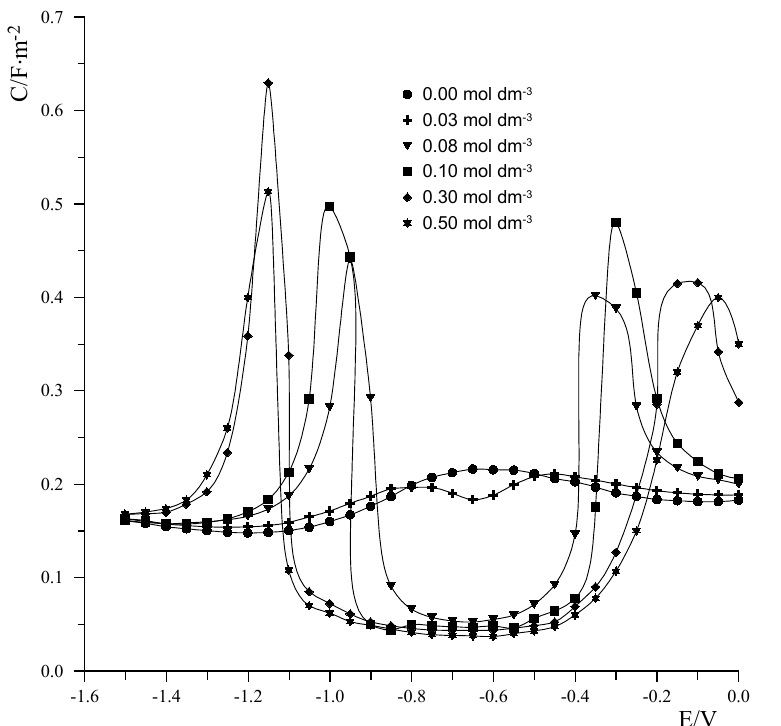
Figure 1. Differential capacity – potential curves at the mercury electrode in contact with 4 mol dm -3 NaClO of tert -butanol as in figure